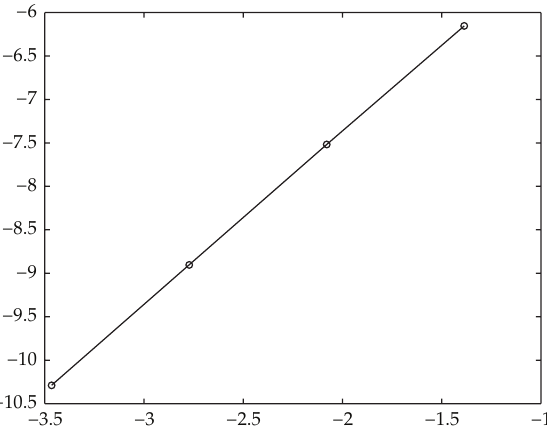
Figure 3: Approximation order of C in L 2 norm, Example 5.1.